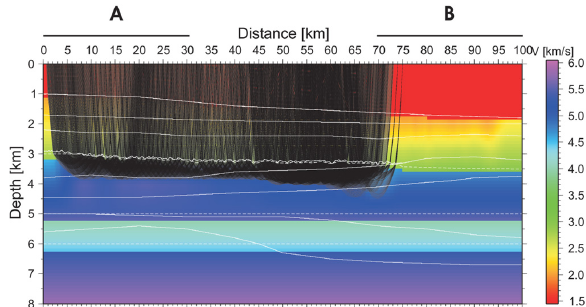
Fig. 7. Results from the basalt refraction inversion using picks from data with noise. White dashed lines represent layers from inversion and continuous lines the theoretical layer interfaces. The black area represents the part of the model sampled by rays. The base of the basalt layer should be delineated by raypaths. The constrain on the thickness of the basalt layer is failing where the layer is thinner, probably due to overpicking refractions.